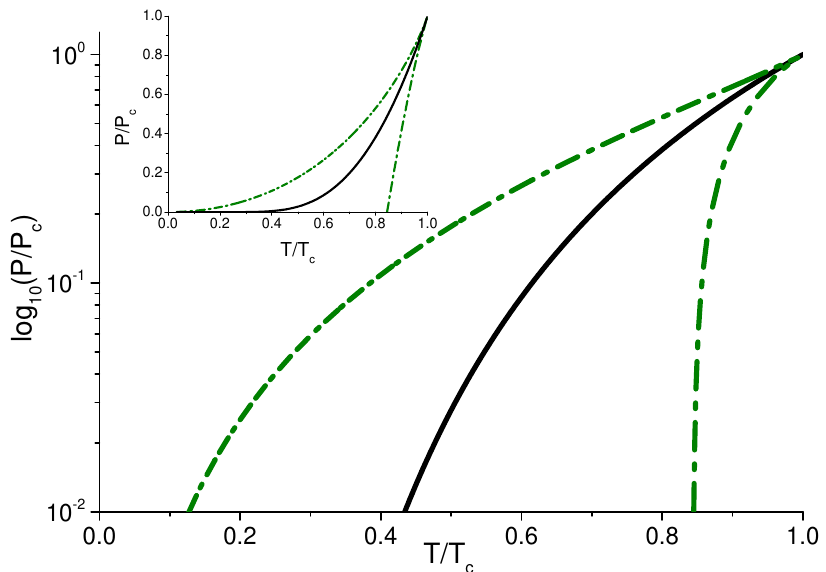
Figure 5. Pressure versus temperature curves (normalized to P c and T c , respectively) for the van der Waals gas. The solid line is the vapor pressure curve, while the two dashed lines indicate the boundaries of the two-phase (liquid–gas) region where the normalized van der Waals equation (Equation (8)) has multiple